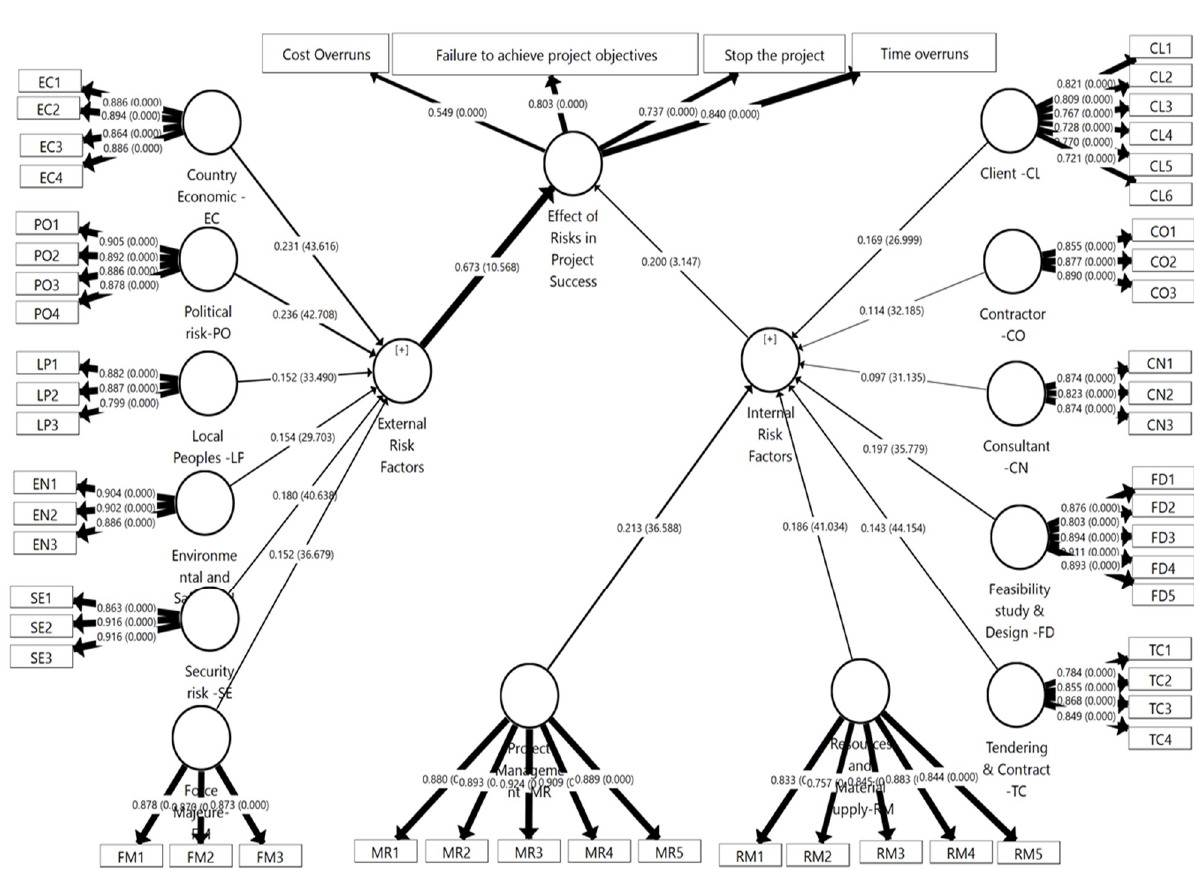
Figure 7. Path Analysis of the Research Hypotheses. Figure 7. Path analysis of the research